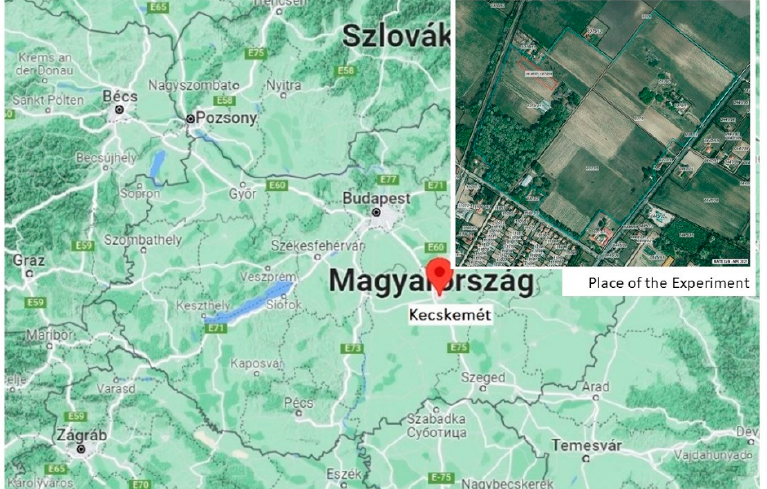
Figure 1. Place of the experiment.